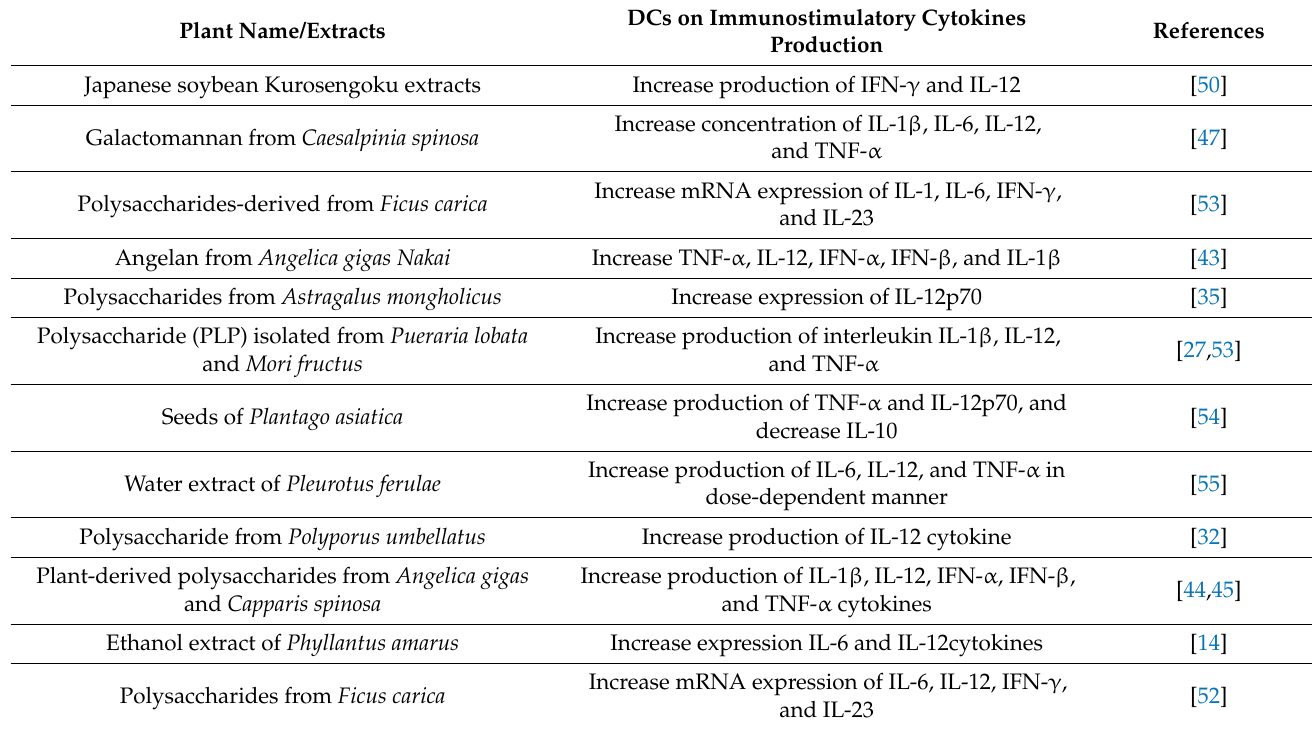
Table 3. Plant extracts stimulated DCs on immunostimulatory cytokines